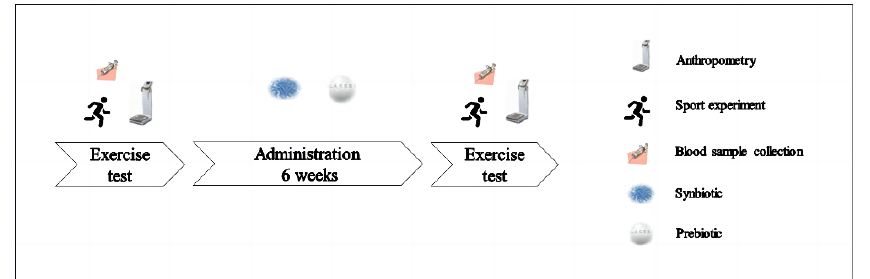
Figure 1. Experimental design.